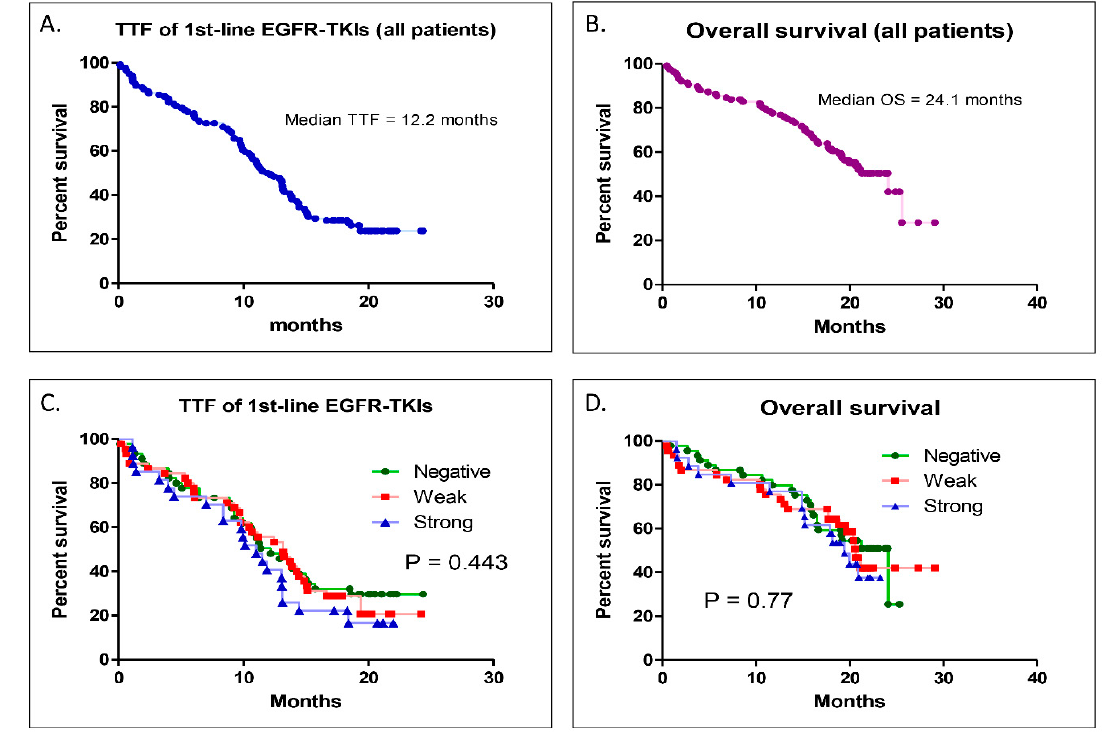
Figure 4. Kaplan–Meier survival analysis of time to treatment failure (TTF) and overall survival (OS). ( A ) TTF for the overall patients of this study. ( B ) OS for all patients of this study. ( C ) Comparison of the TTF between the three different PD-L1 level groups. ( D ) Comparison of the OS between the three different PD-L1 level groups.